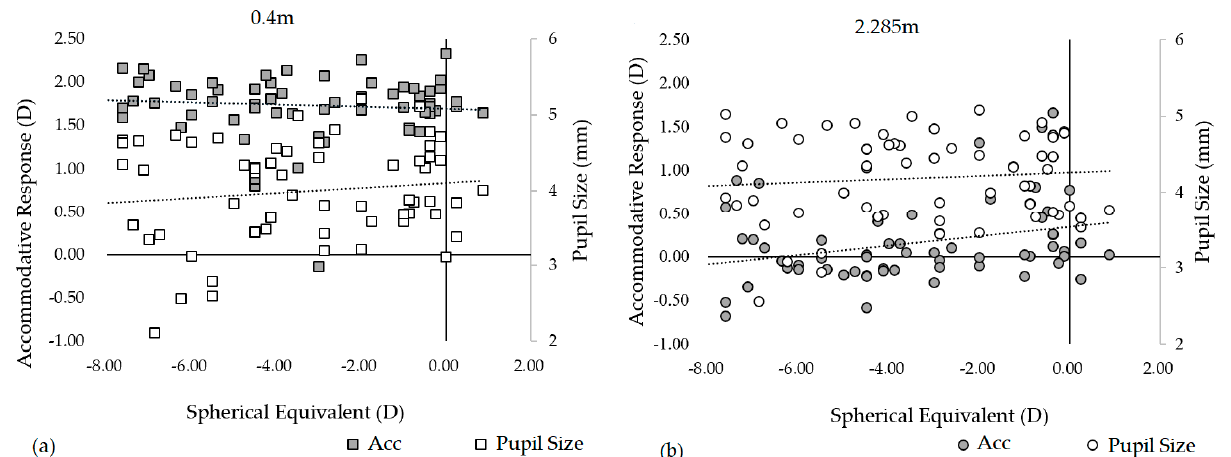
Figure 2. Accommodative response and pupil size distribution for the subjects at the viewing distance of ( a ) 0.4 m and ( b ) 2.285 m.